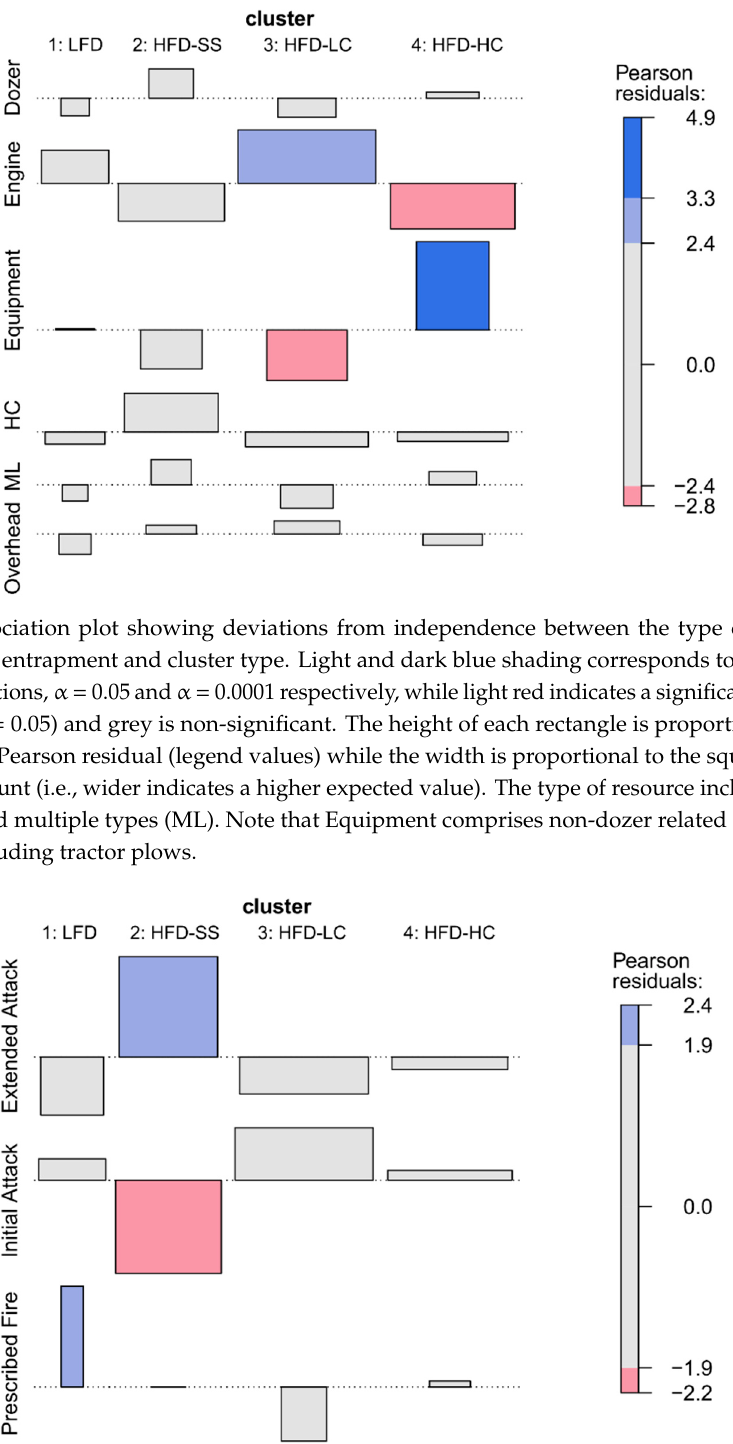
Figure 9. Association plot showing deviations from independence between the incident phase (Management activity) during the time of the entrapment and the cluster type. Light blue shading corresponds to a significant positive association ( α = 0.05), while light red indicates a significant negative association ( α = 0.05) and grey is non-significant. The height of each rectangle is proportional to the corresponding Pearson residual (legend values) while the width is proportional to the square root of the expected count (i.e., wider indicates a higher expected value).